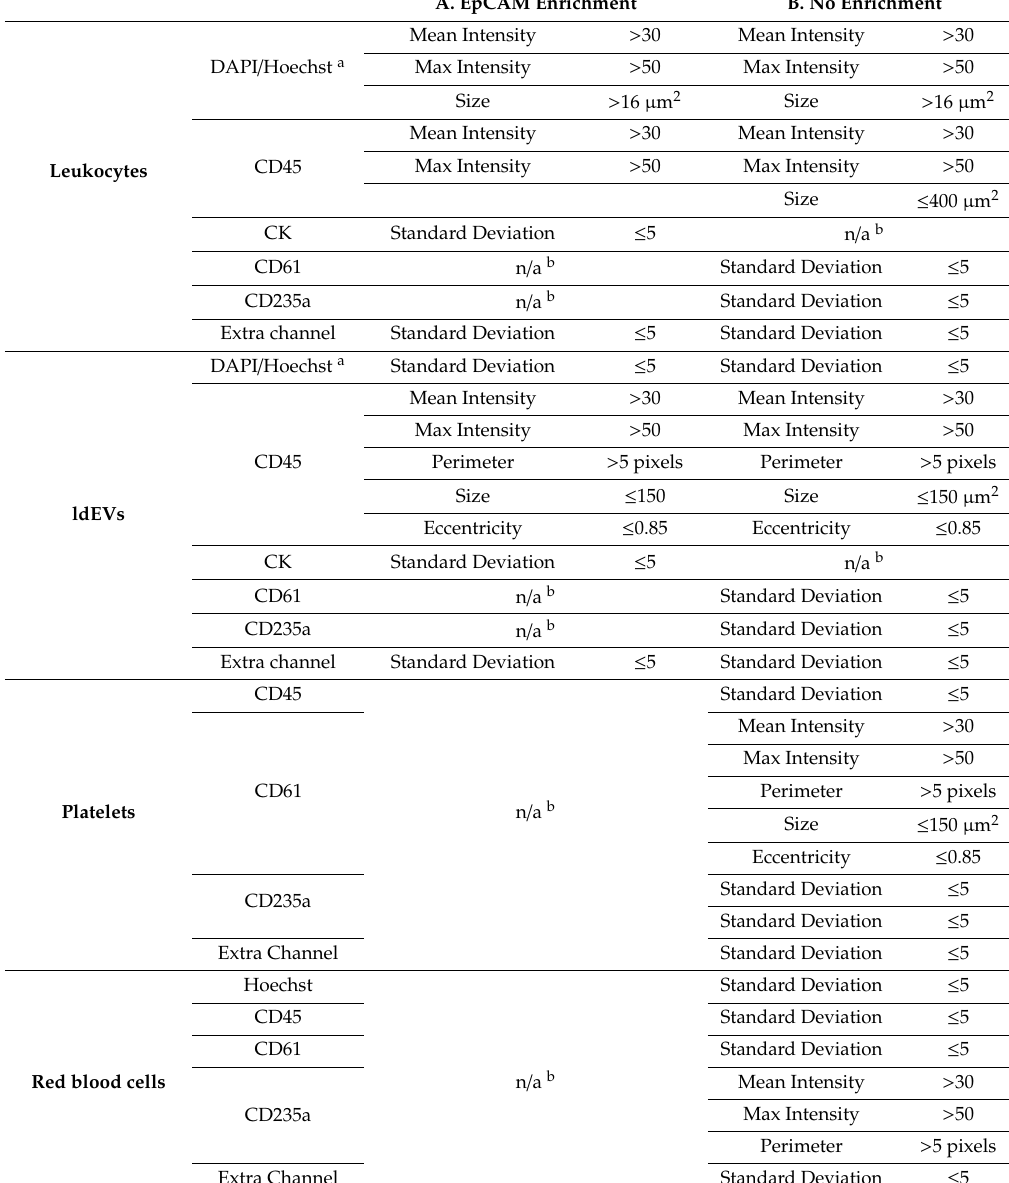
Table 1. ACCEPT gates used for the automated enumeration of leukocytes, leukocyte-derived Extracellular Vesicles (ldEVs), platelets, and red blood cells in blood A with EpCAM enrichment and B without EpCAM